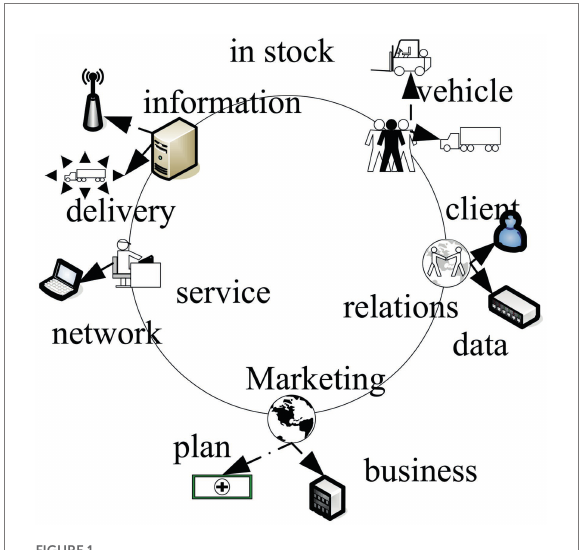
FIGURE 1 Construction mode of information logistics